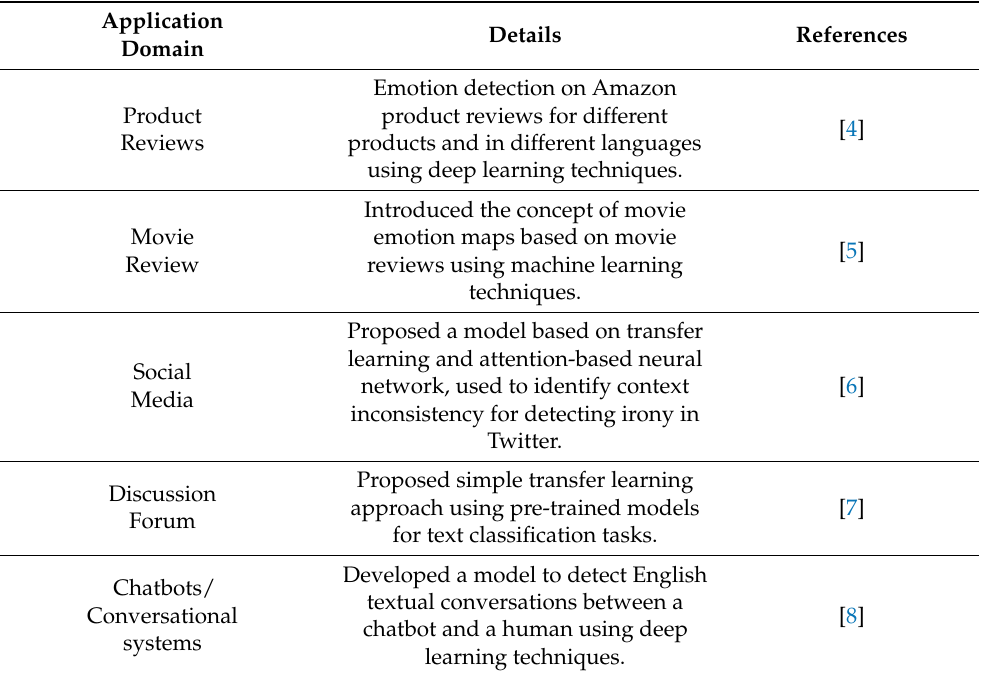
Table 1. Different application domains of text-based emotion